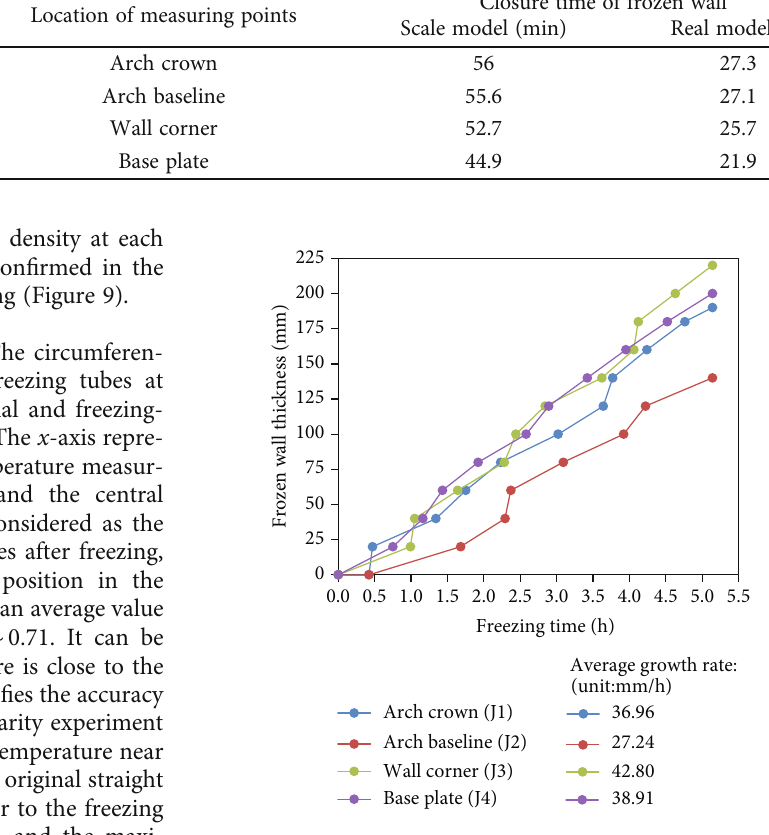
Figure 10: Frozen wall thickness in monitoring section